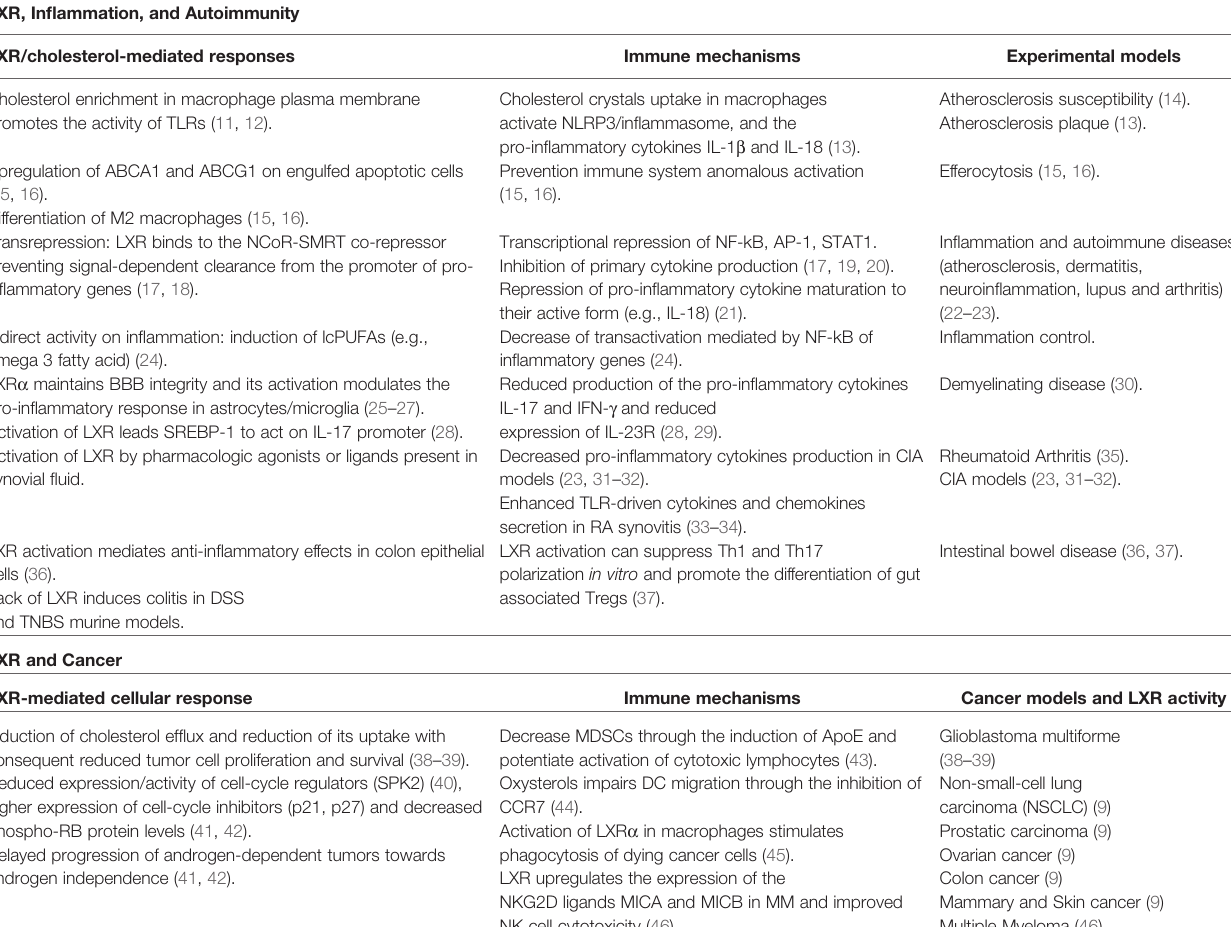
TABLE 1 | Activities of LXR in in fl ammation, autoimmunity, and